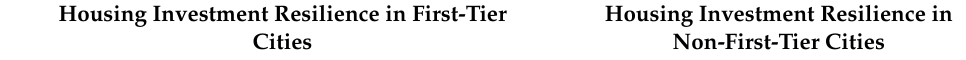
Table 2. Analysis of necessary